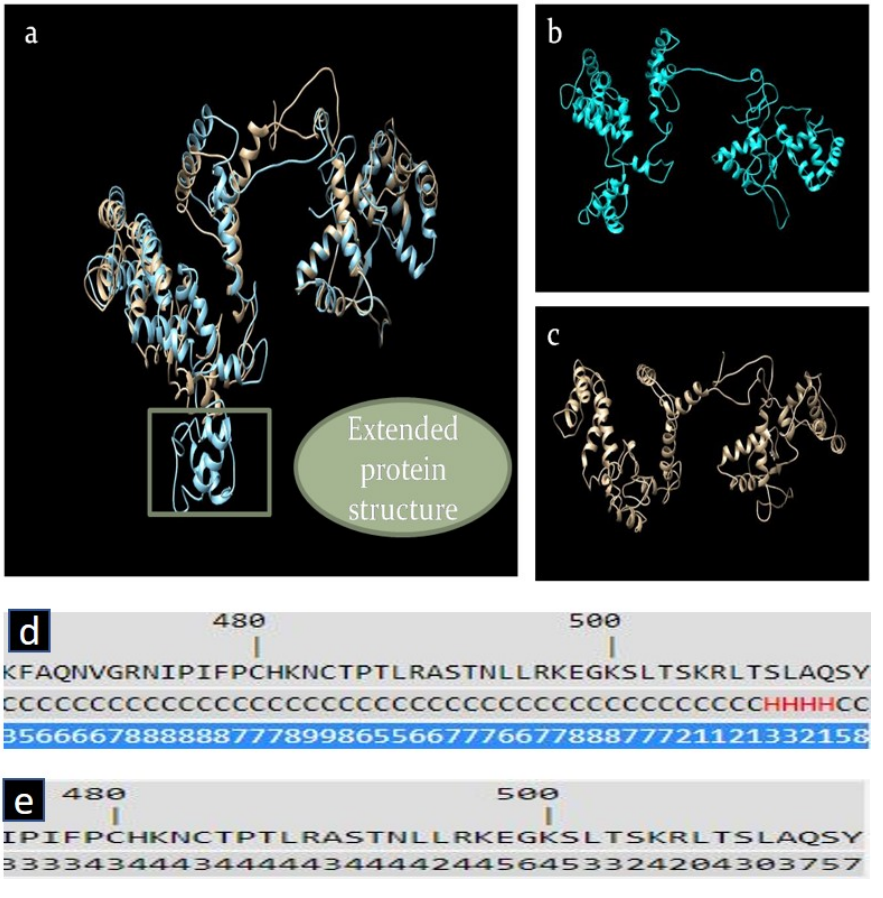
Figure 7. ( a ) Superimposed structure of wild-type and mutant RGS7 proteins. ( b ) Mutant RGS7 protein structure. ( c ) Wild-type RGS7 protein structure. ( d ) Secondary structure prediction of extended protein sequence demonstrated that most of the amino acids were in a coil (C) structure, and only 4 residues were present in the helix (H) structure. ( e ) Solvent accessibility ranged between 0–9. Values range from 0 (buried residue) to 9 (highly exposed residue).